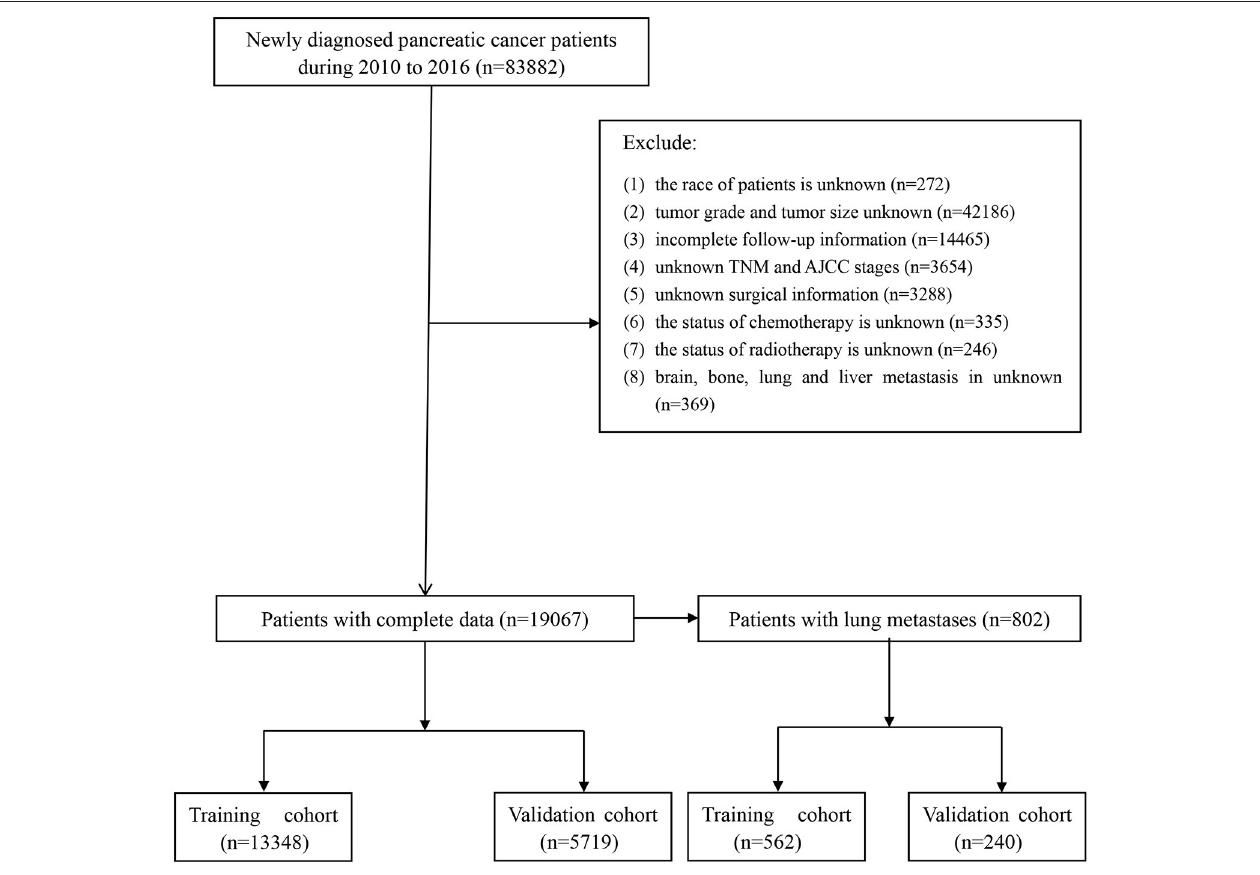
FIGURE 1 | Flowchart of patients identified in this